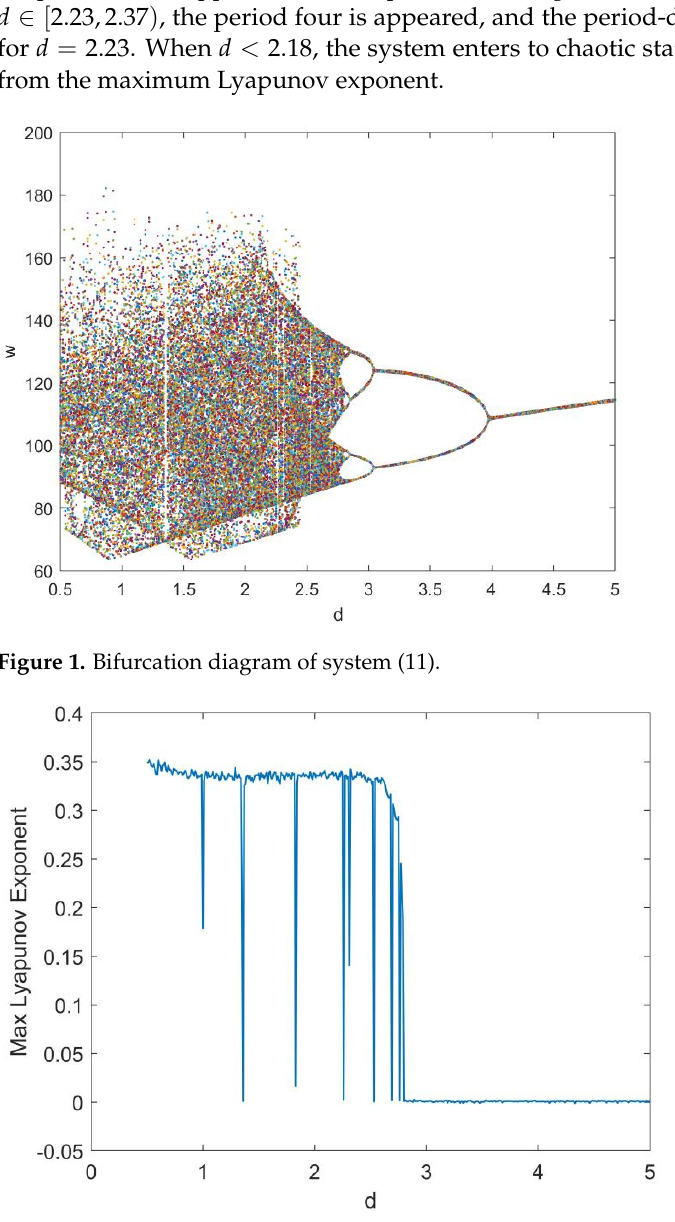
Figure 2. Maximum Lyapunov exponent of system (11).